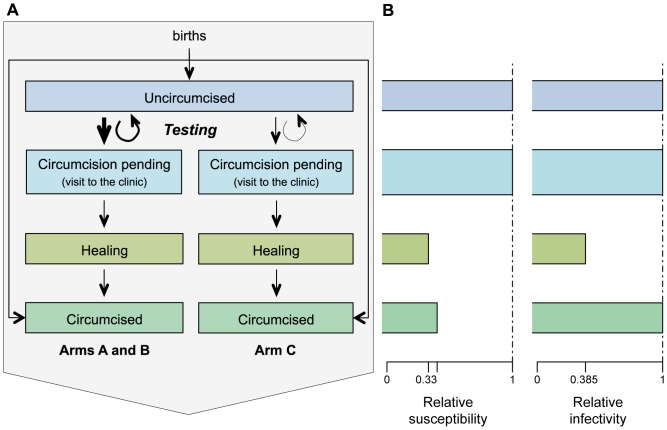
Model structure for susceptible men.
A. Flow diagram of the model. Arrows depict the different flow rates between compartments. Men can be circumcised during childhood (i.e., before the age of 15). If they are not, they can be circumcised following a negative HIV test. Upon testing, some HIV negative men decide to get circumcised. They then enter a “waiting” stage, which encompasses the time from testing to them actually visiting the clinic for circumcision. After circumcision, they go through a healing period, before being circumcised and healed. B. Relative susceptibility and infectivity in the different stages, relative to an uncircumcised man. Relative susceptibility and infectivity of circumcised men in healing period incorporate both biological increases in susceptibility and infectivity and reduction in sexual activity during the healing period (see main text).